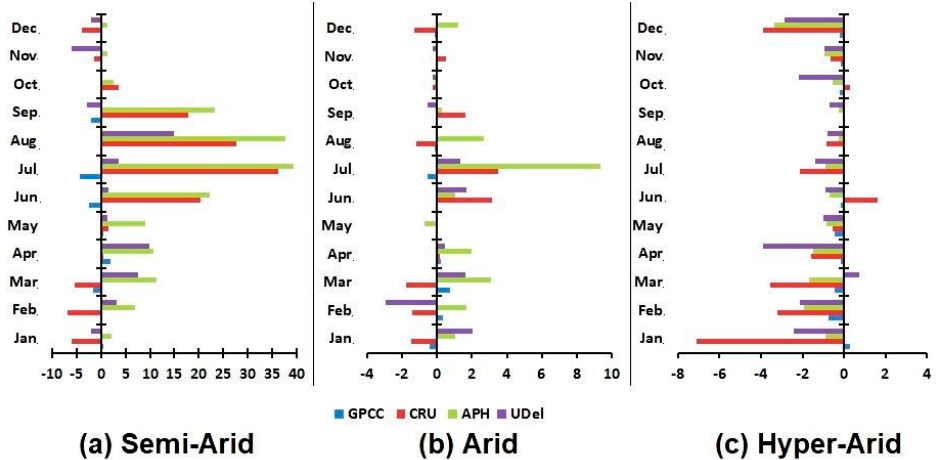
Figure 8. Mean bias error for different gauge-based gridded precipitation data products at ( a ) semi- ( b ) arid, and ( c ) hyper-arid arid, ( b ) arid, and ( c ) hyper-arid stations.